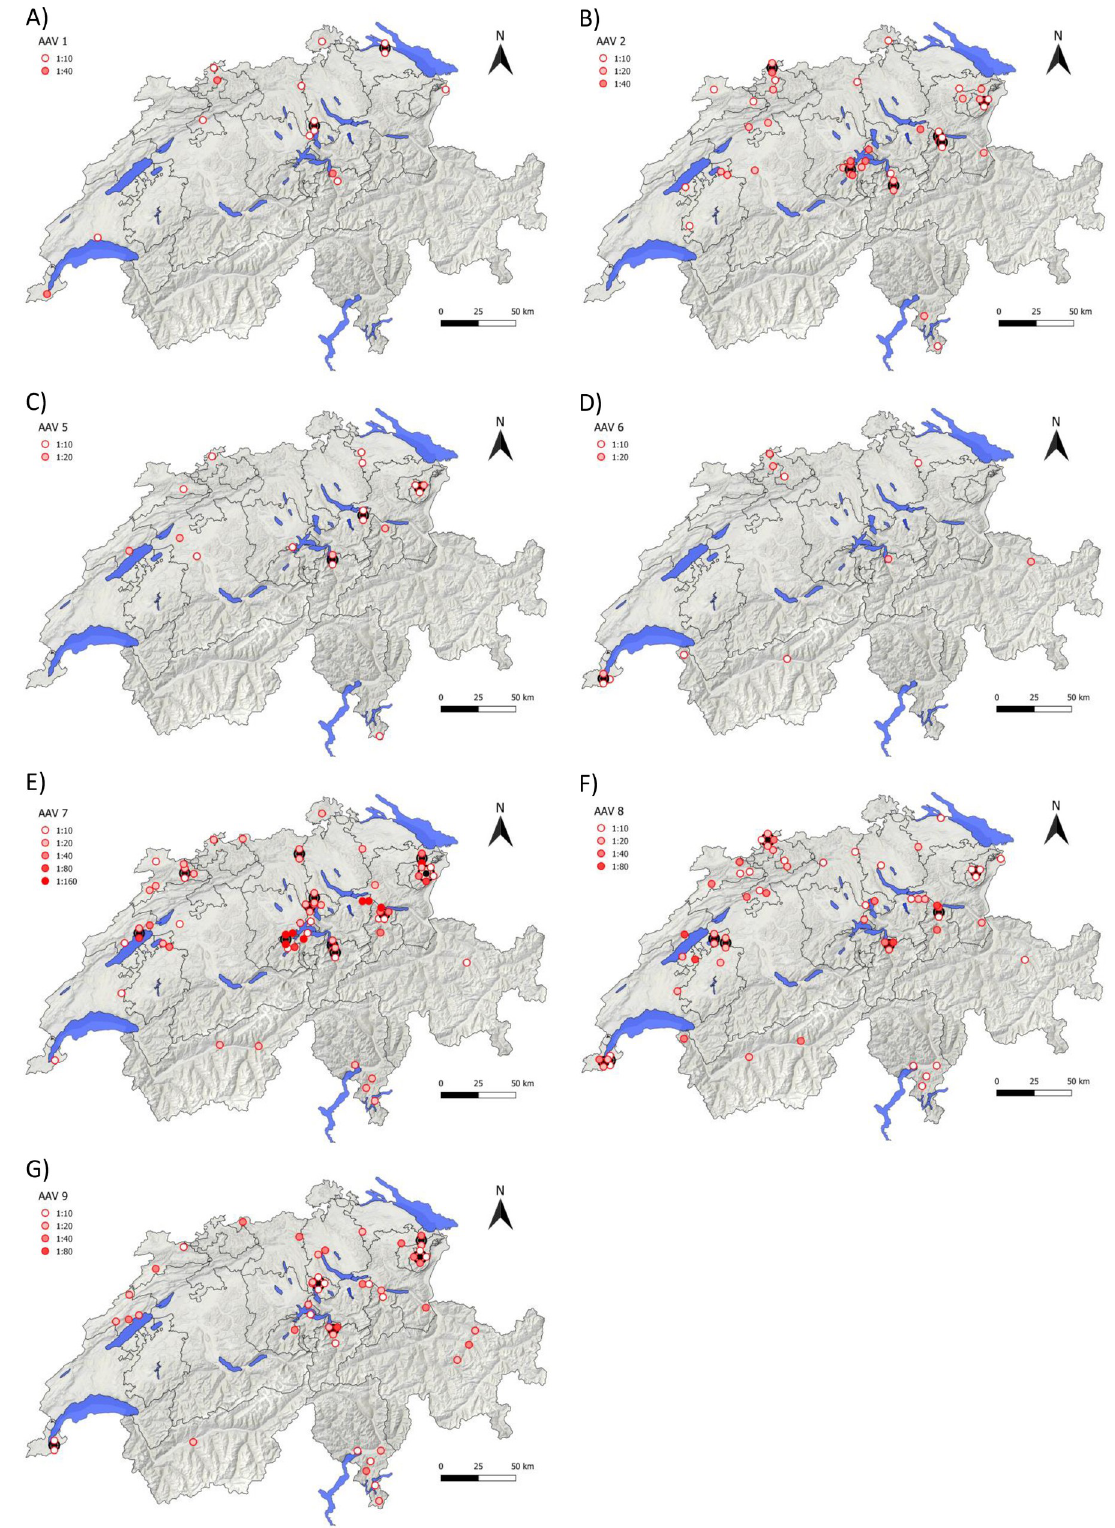
Fig 2. Geographic origin of cats with NAb against AAV in Switzerland. NAb against A) AAV1, B) AAV2, C) AAV5, D) AAV6, E) AAV7, F) AAV8, and G) AAV9 are shown. Dots represent samples with positive NAb against an AAV serotype. Higher color intensity